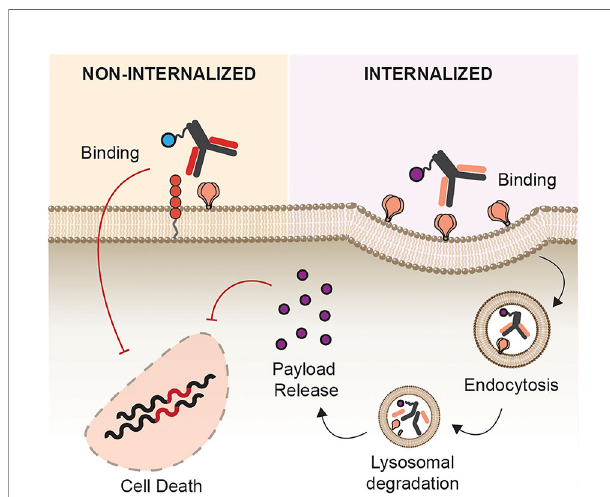
FIGURE 5 | Site of Action. Antibody conjugates can act either intracellularly or intercellularly upon antigen binding. Toxins, siRNA, and inhibitors of DNA synthesis require internalization as they are only functional upon cytosolic release. Payloads such radionuclide, entry inhibitors, and photosensitizers are functional without